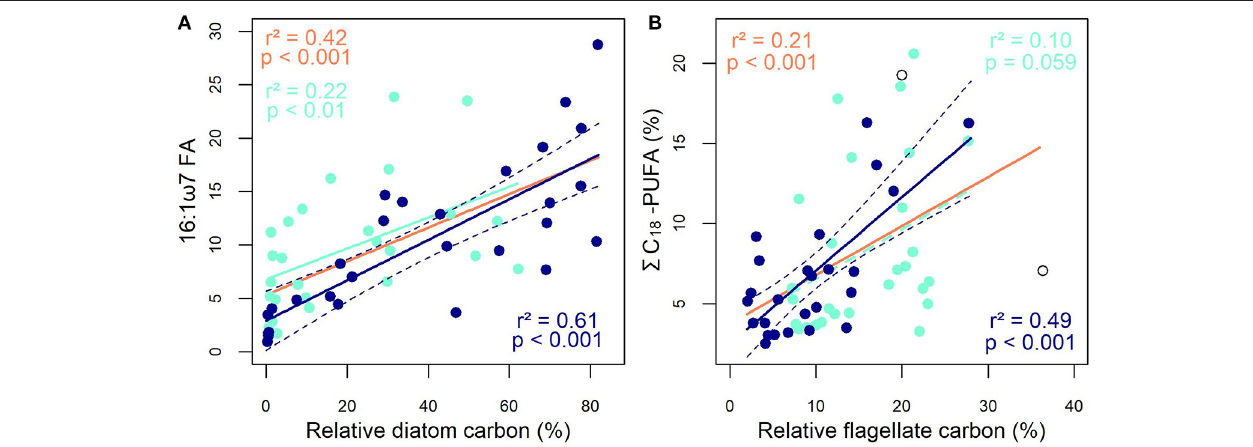
FIGURE 3 | Relationships between (A) the 16:1 ω 7 FA proportion and the relative carbon biomass of diatoms and between (B) the 6 C 18 -PUFA proportion and the relative carbon biomass of flagellates. The dark-blue symbols, lines and text represent the subsurface chlorophyll maximum (SCM), the turquoise symbols, lines and text represent the surface (SUR) while the orange lines and text represent the SCM and SUR data combined. The dashed dark-blue line represents the 95% confidence interval and open circles represent outliers in the SCM dataset (Grubbs test, p <